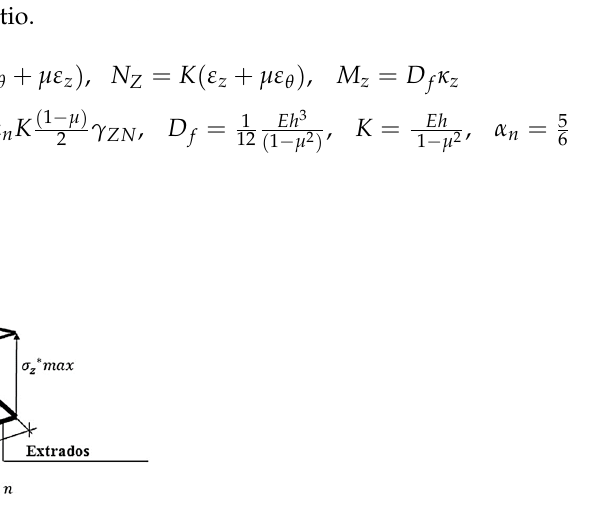
Figure 2. Linear distribution of the normal stress ( σ z ∗ ) , disregarding the constitutive curvature of the shell.